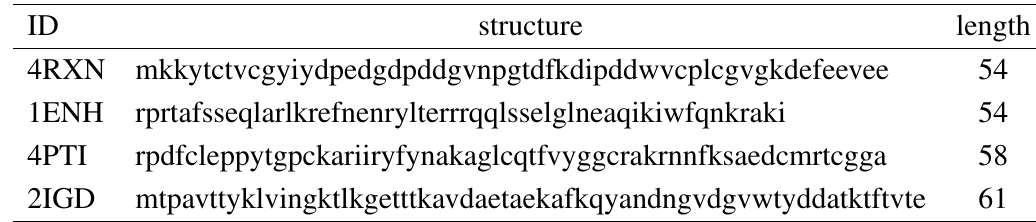
Table 3. M-J Model benchmark problems for 3D FCC lattices from